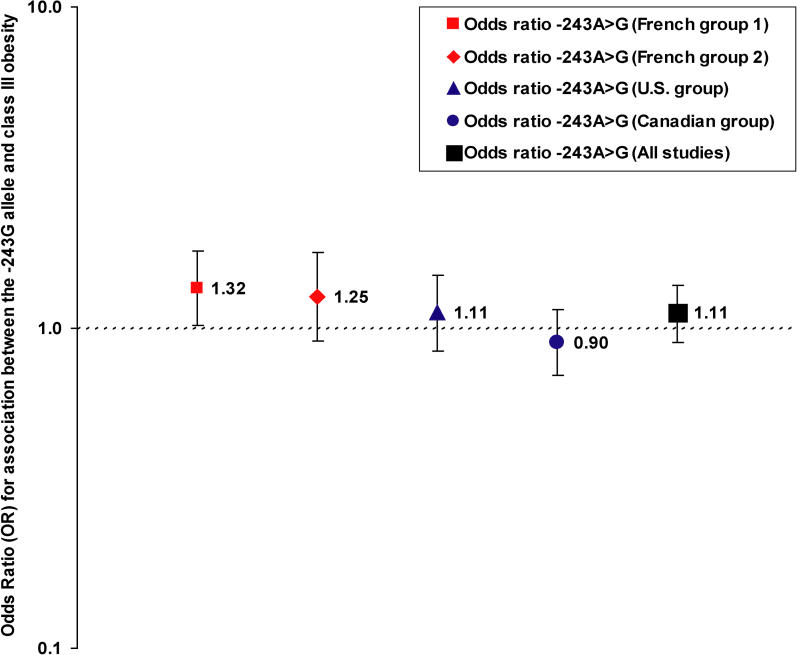
Meta-Analysis for the Association between the GAD2 −243 A>G Polymorphism and Class III ObesityFrench groups 1 and 2 refer to the genotype results from two sets of Caucasian class III obese cases and controls studied by Boutin et al. [18]. US and Canadian groups were from the present study. The meta-analysis for the association between the −243 G allele and class III obesity yielded a summary OR of 1.11 (95% CI 0.90–1.36), obtained in a total sample of 1,252 class III obese cases and 1,800 controls using a Mantel-Haenszel method and a fixed effects model.